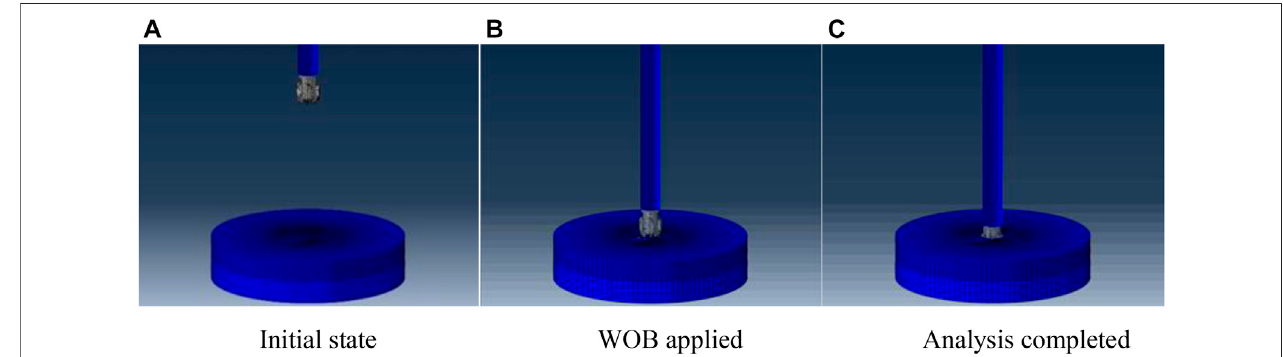
FIGURE 4 | Deformed shapes in different stages.